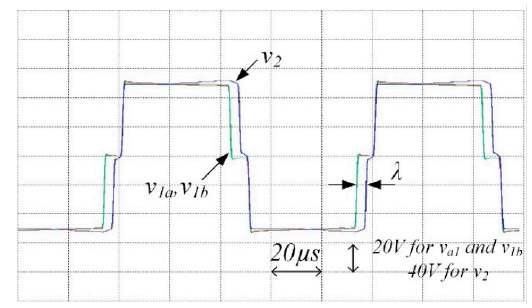
Figure 12. Voltages across windings of the proposed system fed from PPSs emulating PV modules at the rated condition.